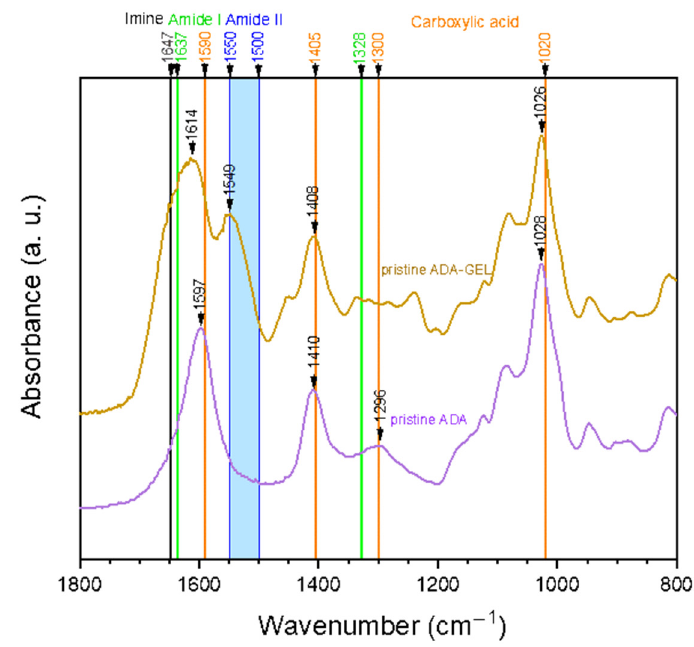
Figure 1. ATR-FTIR spectra of pristine alginate di-aldehyde (ADA) and alginate covalently crosslinked with gelatin (ADA-GEL). The relevant peaks are discussed in the text.